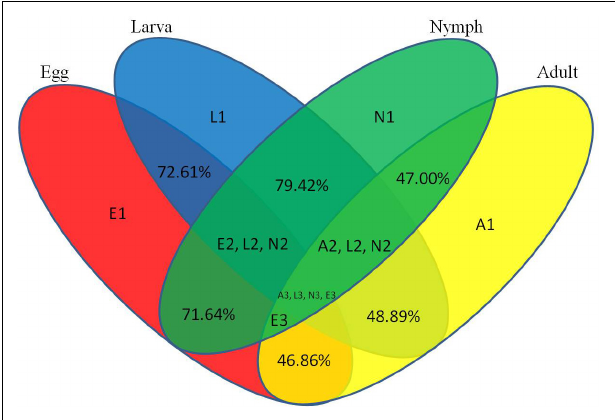
FIGURE 2 | Common and specific unique tag sequences among samples. The percentages indicate common microRNAs among developmental stages. E1, L1, N1, and A1 indicate specific microRNAs in eggs, larvae, nymphs, and adults, respectively. “E2 L2 N2” indicates common microRNAs in eggs, larvae, and nymphs. “A2 L2 N2” indicates common microRNAs in adults, larvae, and nymphs. “E3” indicates common microRNAs in adults, eggs, nymphs, and adults. “A3 L3 N3 E3” indicates common microRNAs in all developmental